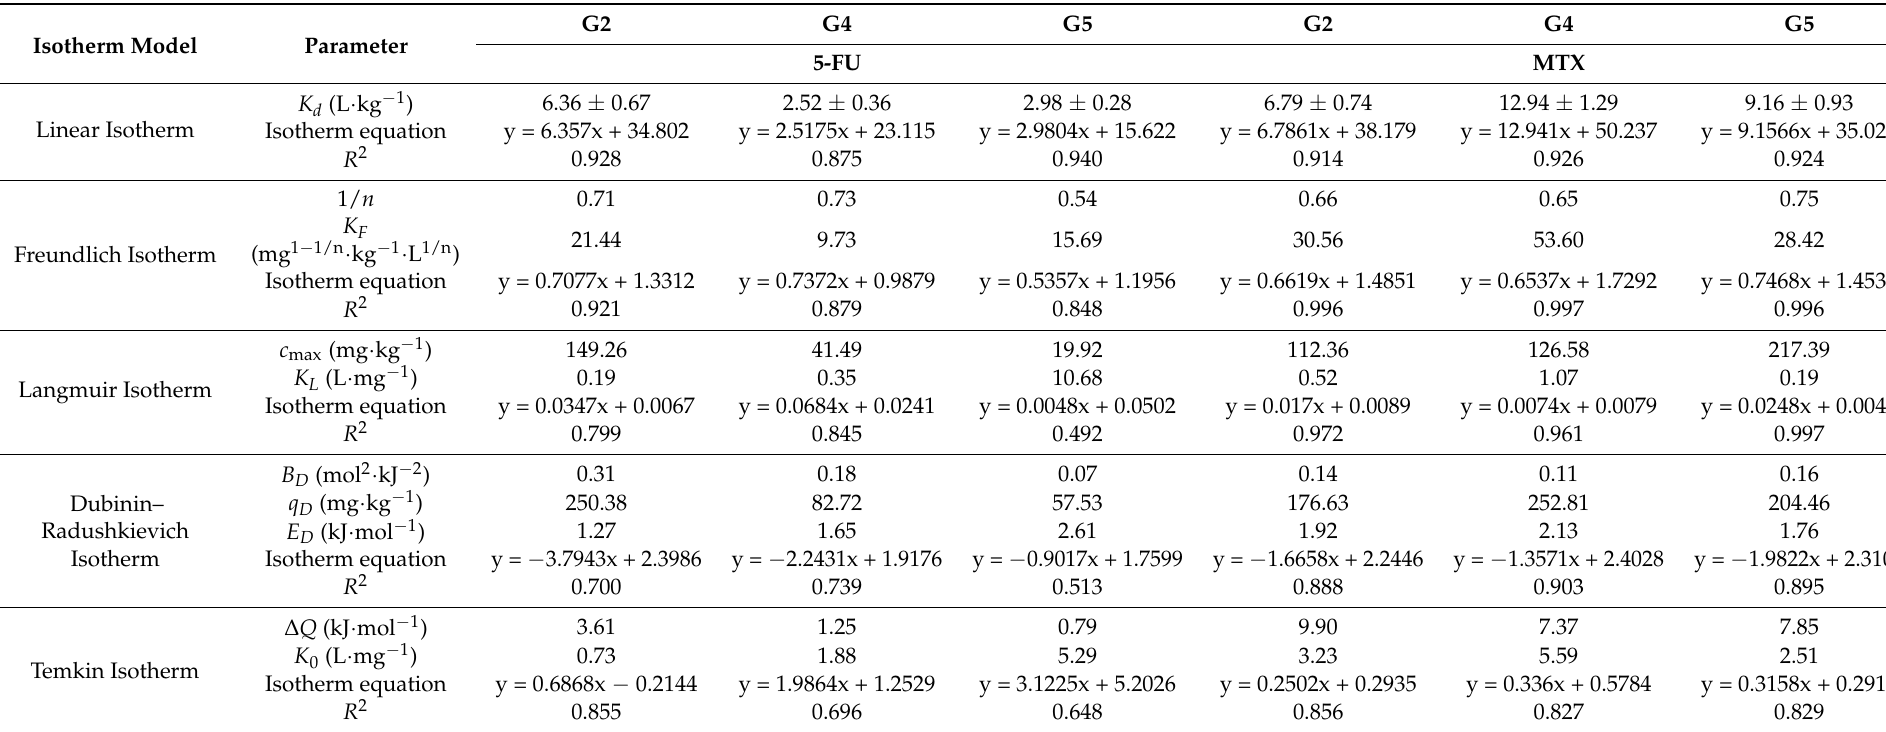
Table 2. Isotherm parameters of adsorption of 5-fluorouracil (5-FU) and methotrexate (MTX) onto soils G2 (alluvial soil), G4 (acid brown soil), and G5 (acid and leached brown